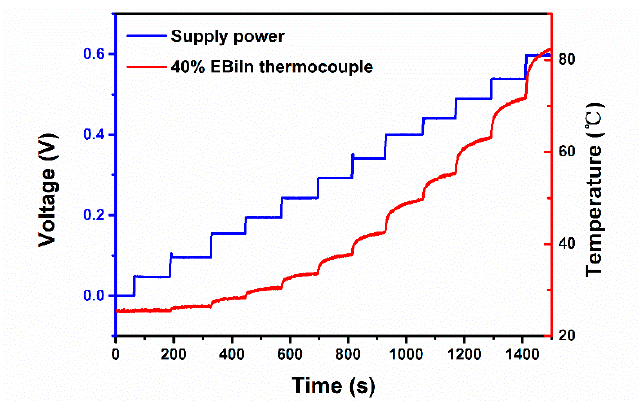
Figure 6. Experimental results of the performance test of thermocouple. The thermocouple with 40% ratio of EBiIn was used to monitor the temperature change of GaInSn microheater.